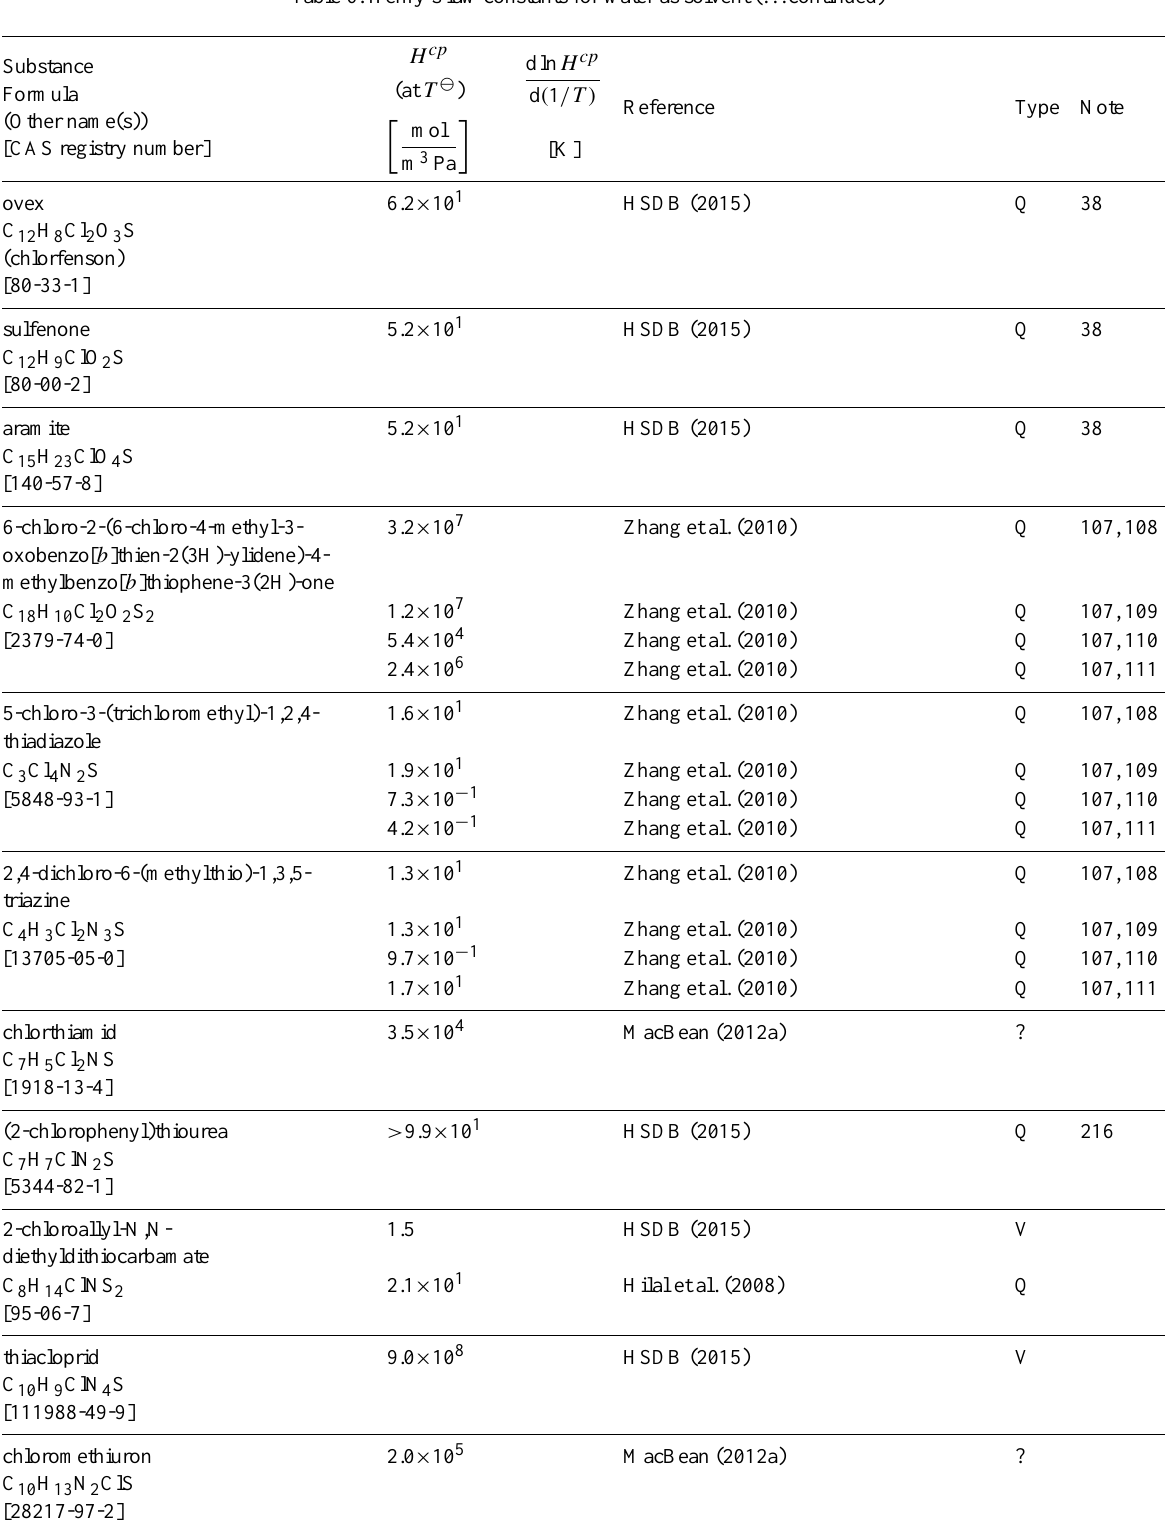
Table 6: Henry’s law constants for water as solvent